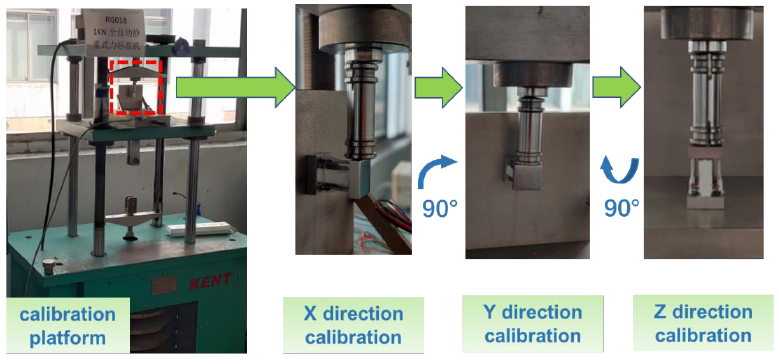
Figure 4. Sensor calibration.